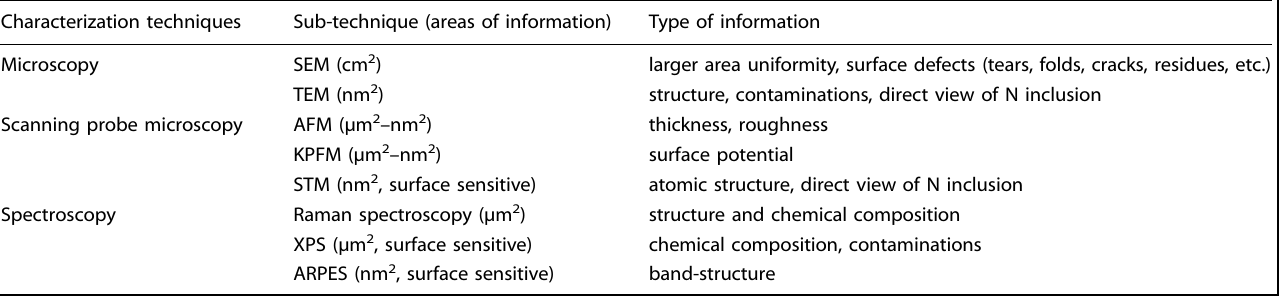
Table 3. Summary of various characterization techniques used for CVD-grown NDG (the abbreviated technique names are de fi ned in the main text, e.g., - SEM).